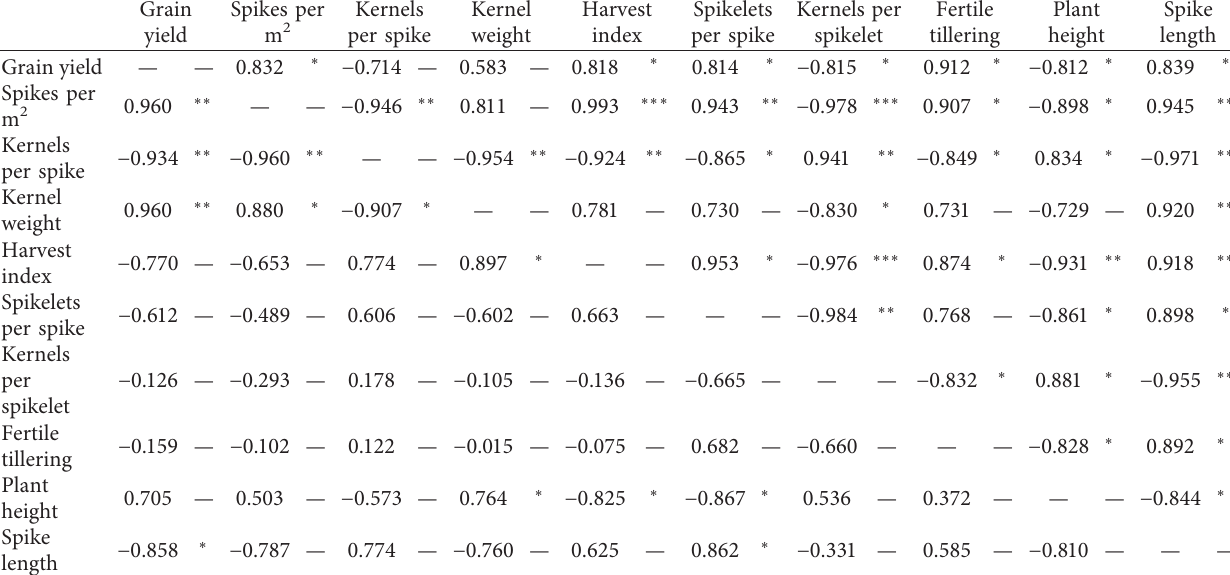
Table 6: Correlations between analyzed traits in six durum wheat varieties released in different periods (old, intermediate, and modern) grown under two water regimes: irrigated (upper right diagonal) and rainfed (lower left diagonal) during three growing seasons (2017, 2018, and 2019).